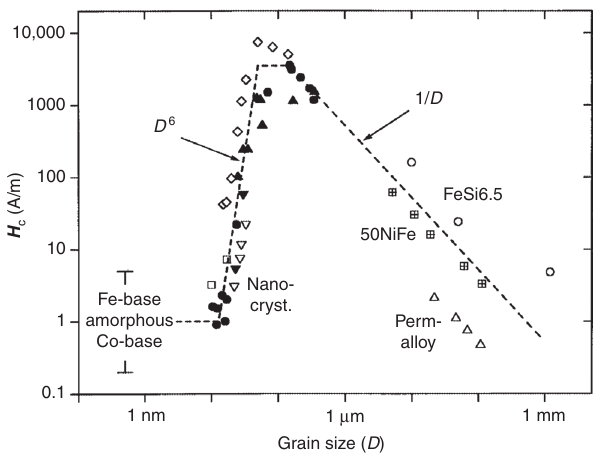
) vs. grain size (D), for various soft magnetic Figure 4 Coercivity ( H c metallic alloys (Herzer [12], Copyright